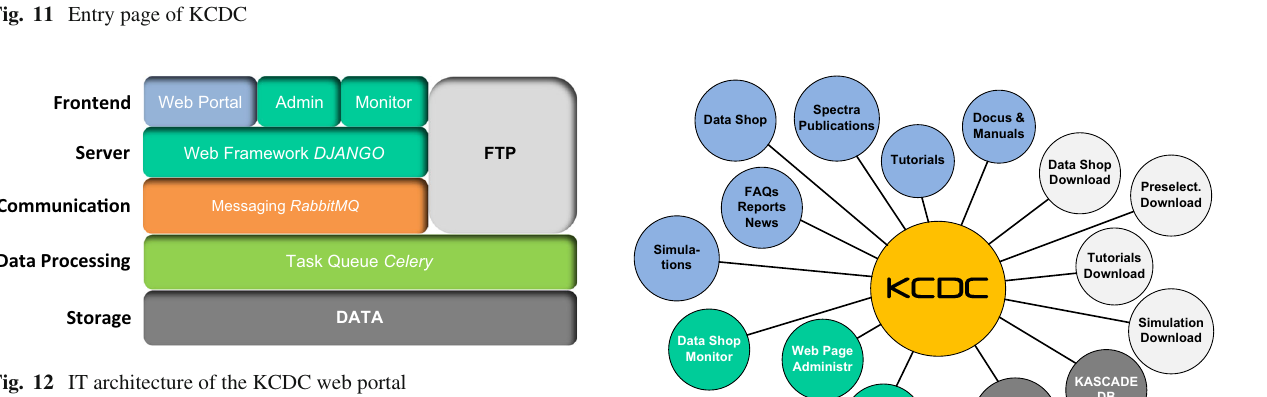
Fig. 12 IT architecture of the KCDC web portal